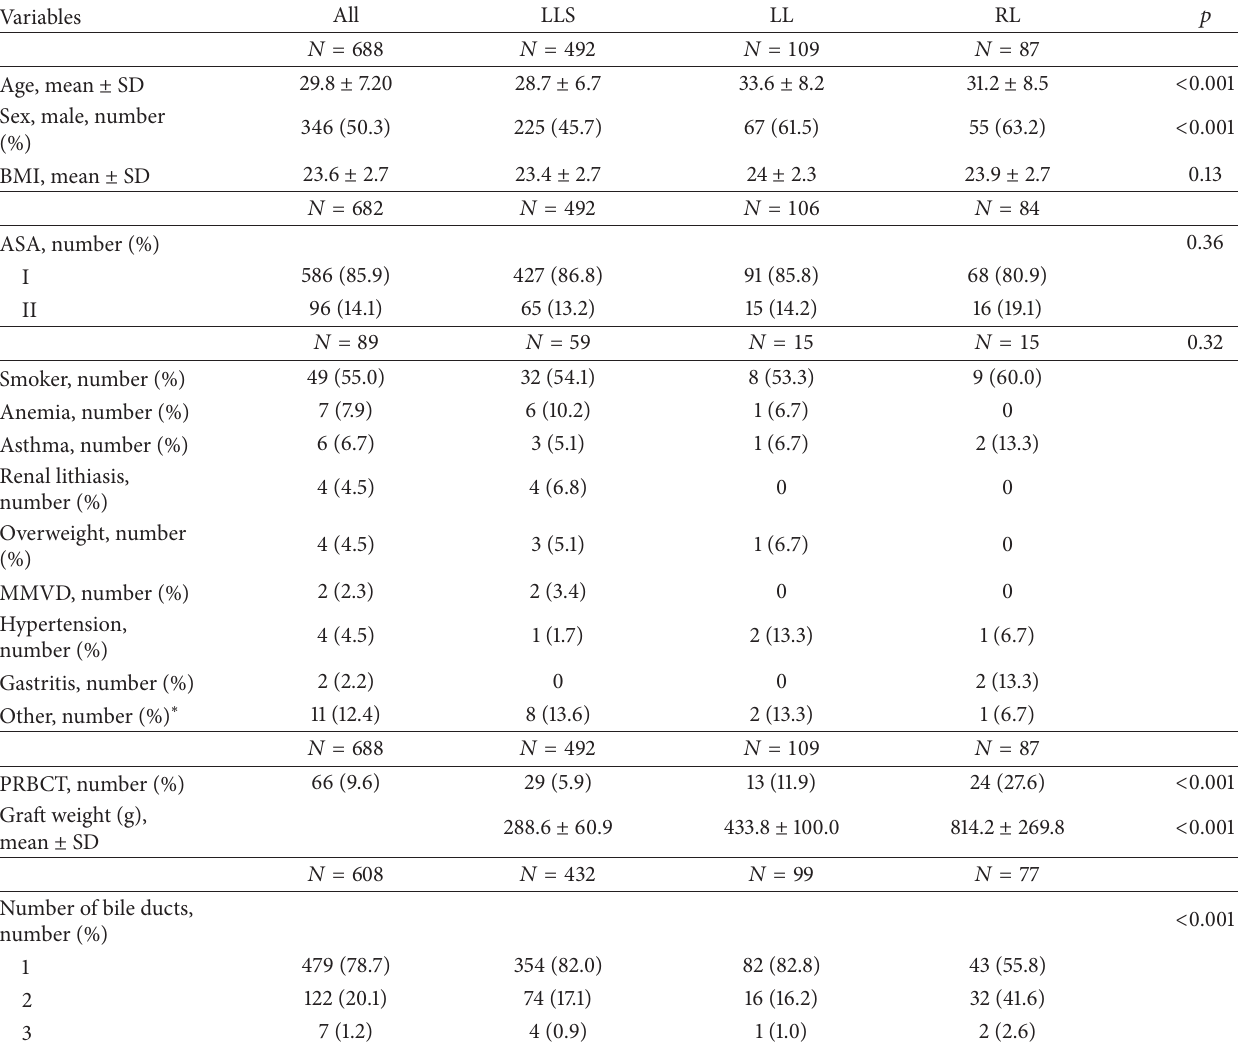
Table 1: Preoperative and intraoperative variables according to the type of liver resection.